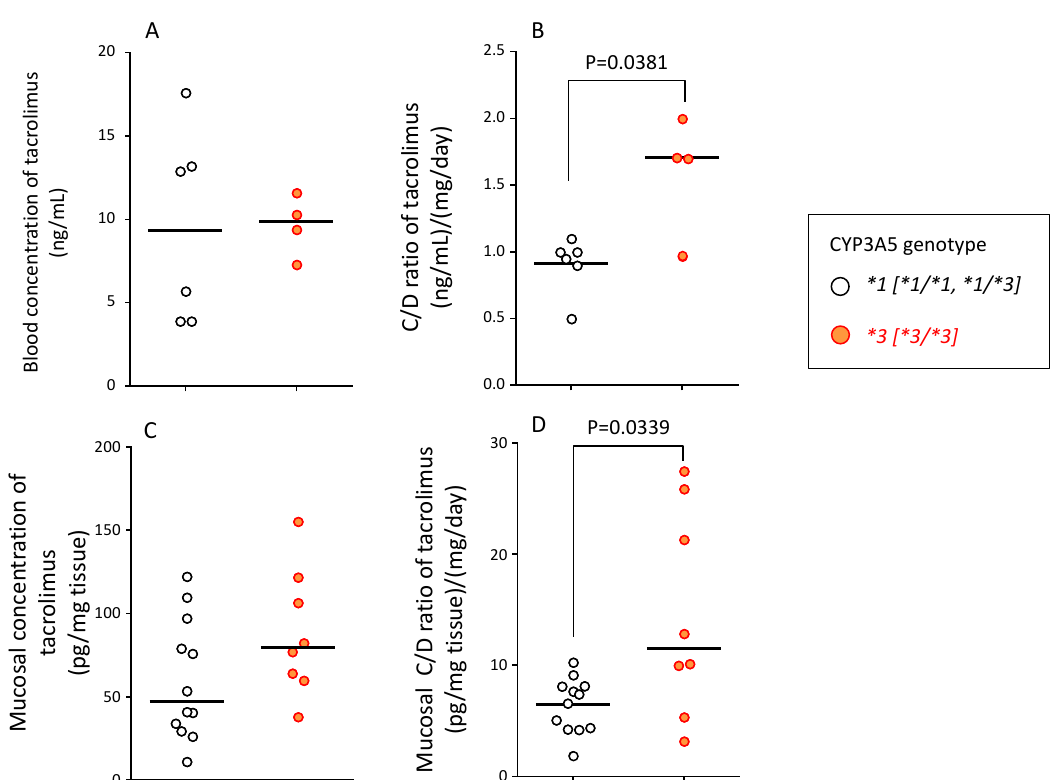
Figure 5. Relationship between CYP3A5 genotype and blood concentration ( A ), blood C / D ratio ( B ), mucosal concentration ( C ), and mucosal C / D ratio ( D ) of tacrolimus at endoscopic examination. ( A ) The blood concentration of tacrolimus in patients carrying the CYP3A5*1 allele and CYP3A5*3 / *3 genotype is shown. ( B ) The blood concentration / dose (C / D) ratio of tacrolimus in patients carrying CYP3A5*1 allele and CYP3A5*3 / *3 genotype is shown. ( C ) The concentration of tacrolimus in the mucosal tissue of biopsy specimens at endoscopic examination is shown. Two biopsy specimens were taken per patient to measure the tissue concentration of tacrolimus to account for intra-individual variation. ( D ) The mucosal concentration / dose (C / D) ratio of tacrolimus in patients carrying the CYP3A5*1 allele and CYP3A5*3 / *3 genotype is shown. Two data points per patient of C / D ratio were used to account for intra-individual variation. The bar shows the median in each group. Statistical analyses were performed using the Mann–Whitney’s U -test.